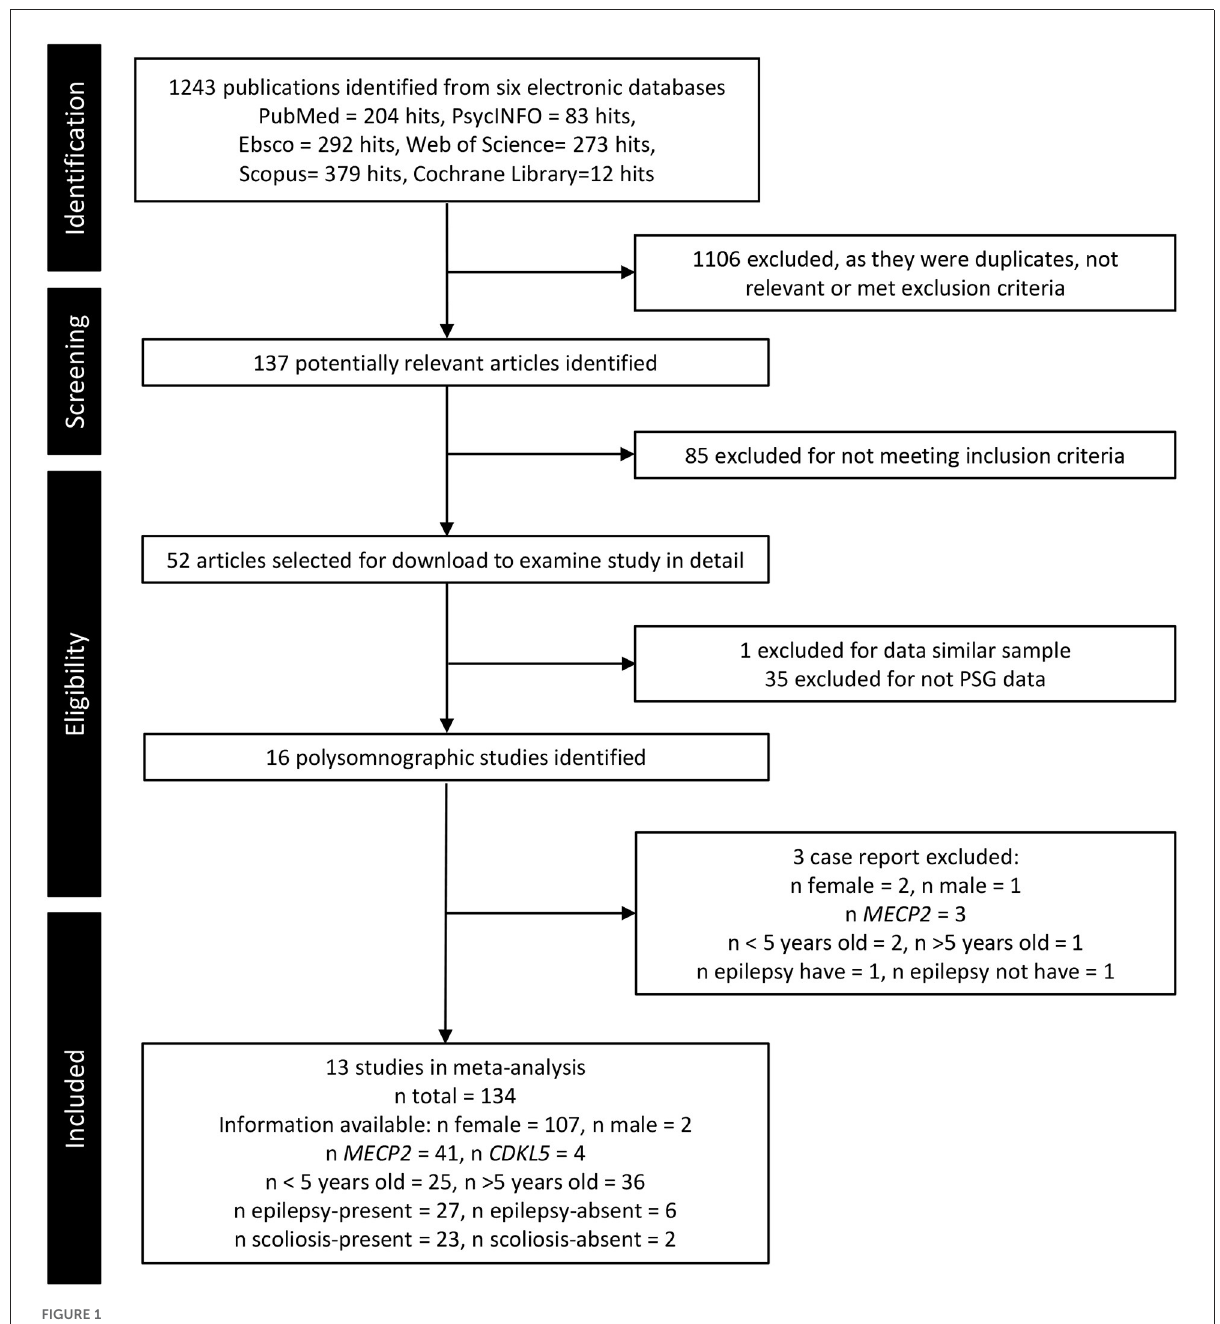
FIGURE1 Flowchart of article selection up to date of 26 April 2022.